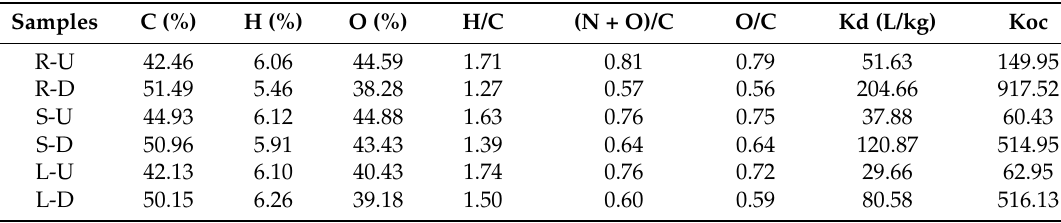
Table 4. Elemental composition and atomic